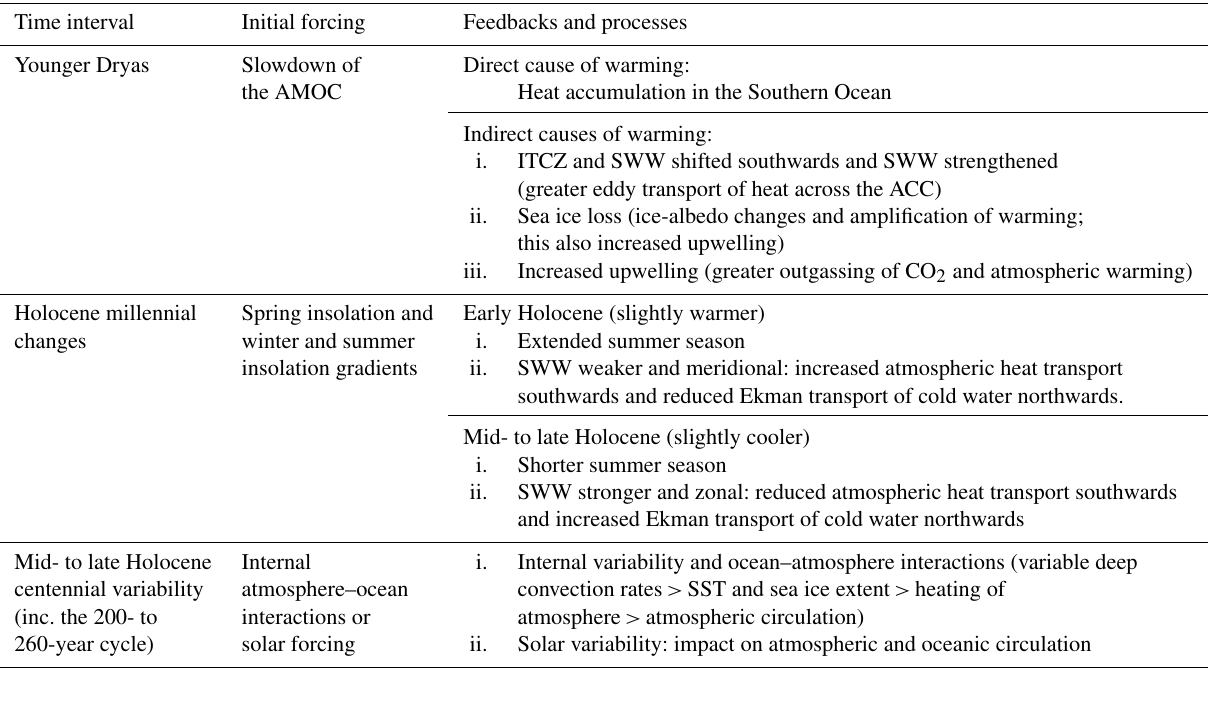
Table 2. Summary table of the suggested forcings of the core COR1GC SST reconstruction, as proposed in Sect. 5.2. Time interval